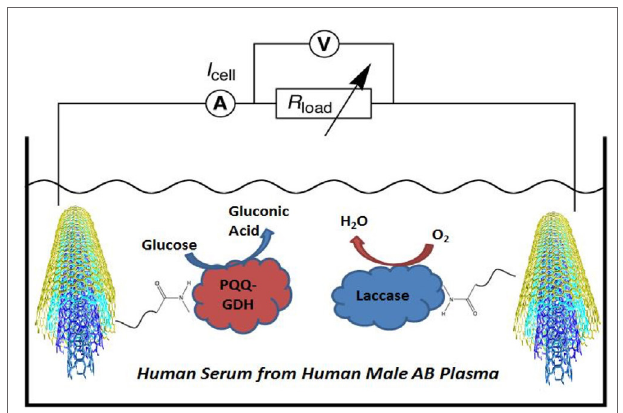
FigUre 1 | Functionalized MWcnT-buckypaper-based biofuel cell operating in human serum from human male aB plasma . Bioelectrocatalytic reactions are based on the glucose oxidation by the PQQ-GDH and H 2 O 2 -reduction by laccase at anode and cathode,